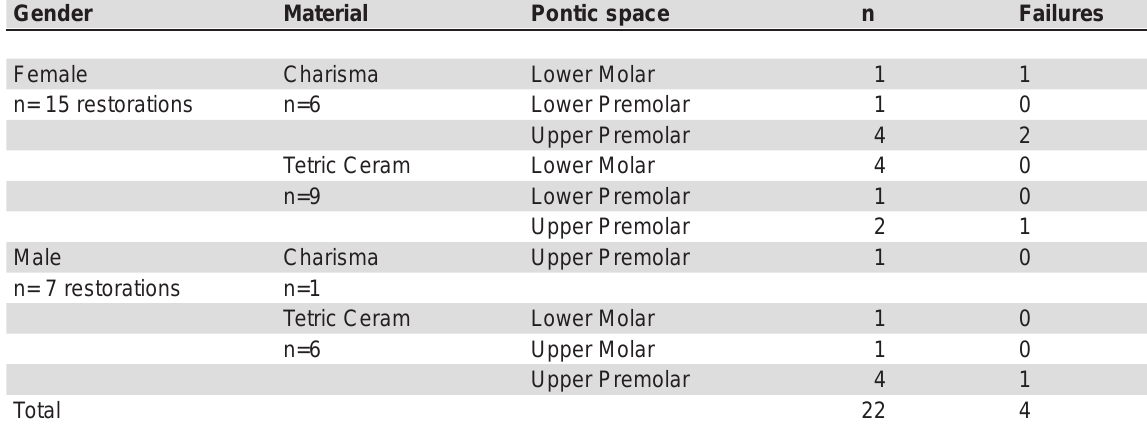
Table 1- Description of the patients and inlay fiber-reinforced composite fixed partial dentures